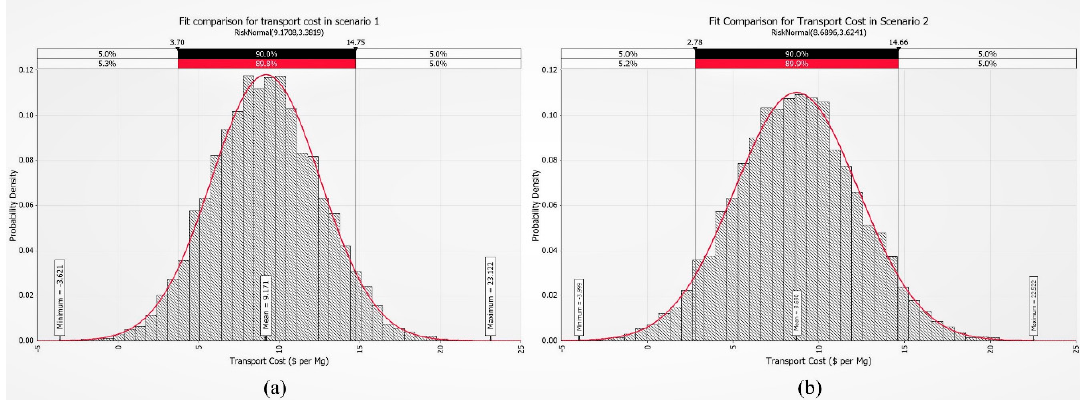
Figure 7. Transportation cost mean by refineries. ( a ) in scenarios 1, ( b ) in scenario 2.